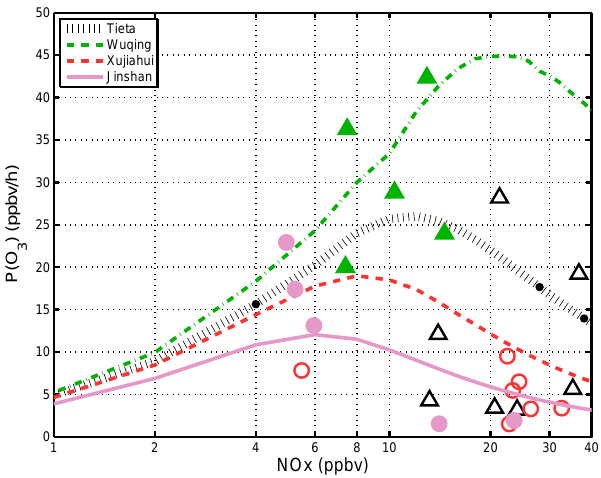
Fig. 5. Simulated instantaneous production rates of ozone (ppbvh − 1 ) as a function of NO x (ppbv). Model results using the two chemical inputs are illustrated in the same colour for each site. Lines represent model results from prescribed NO x concentrations and NMHC measurements averaged over the whole sampling pe- riod. Markers represent model results from both measured NO x and NMHCs on each day of the sampling period if